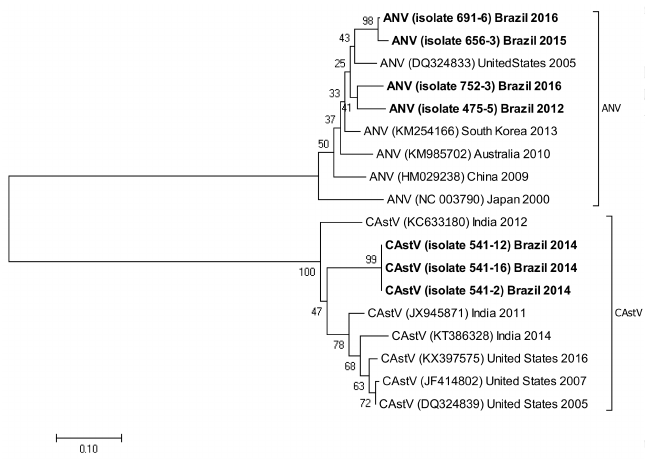
Figure 2. Phylogenetic tree for ANV and CAstV strains, was inferred with the neighbor-joining statistical method and based on the partial sequence of the ORF-1b gene in both of them. Numbers along the branches refer to bootstrap values for 1000